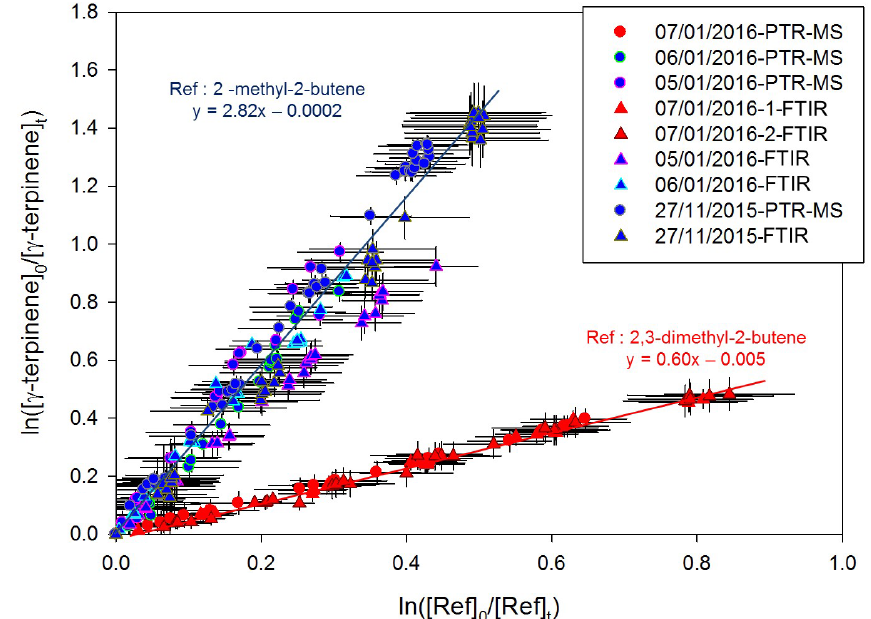
Figure 2. Relative kinetic plots measured by FTIR spectrometer (triangle marks) and PTR-ToF-MS (round marks), with 2-methyl-2-butene (blue) and 2,3-dimethyl-2-butene (red) as reference compounds.